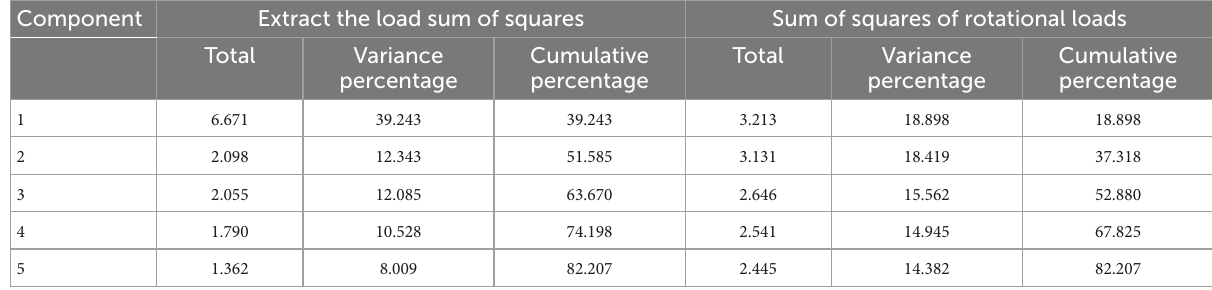
TABLE 5 Principal component analysis was used to extract the